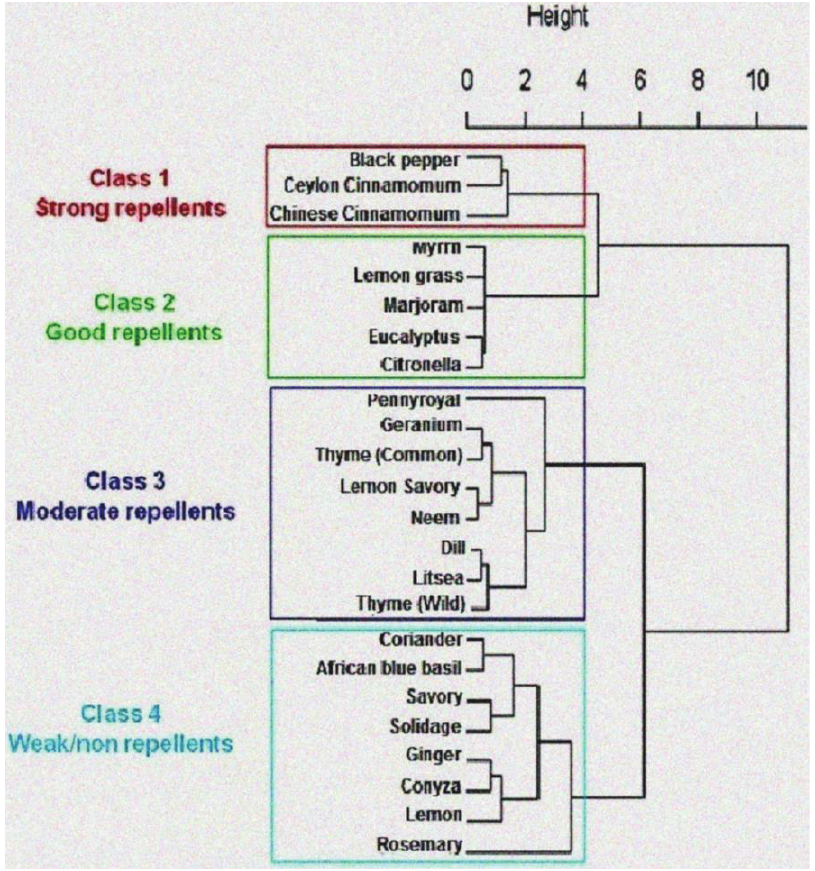
Figure 2. Dendrogram representing response of female M. sjostedti to the pooled interaction effect of extracts and